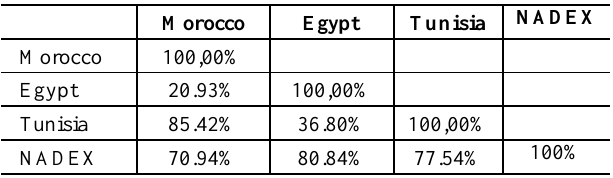
Plot of WADEX (West Africa Index) versus the Constituent Markets (Figure 11)